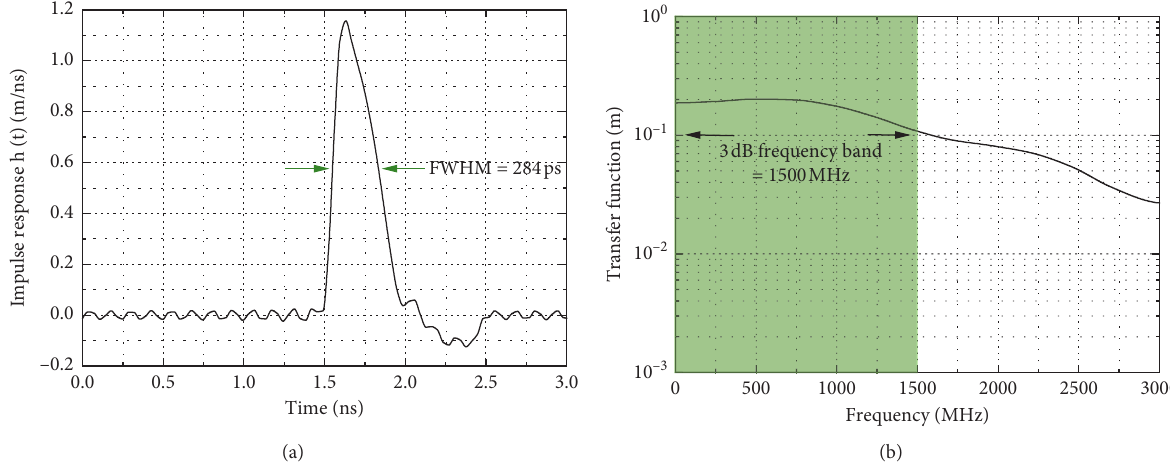
Figure 3: The performance of combined time-domain antenna. (a) Impulse response in time domain. (b) Transfer function in frequency domain.